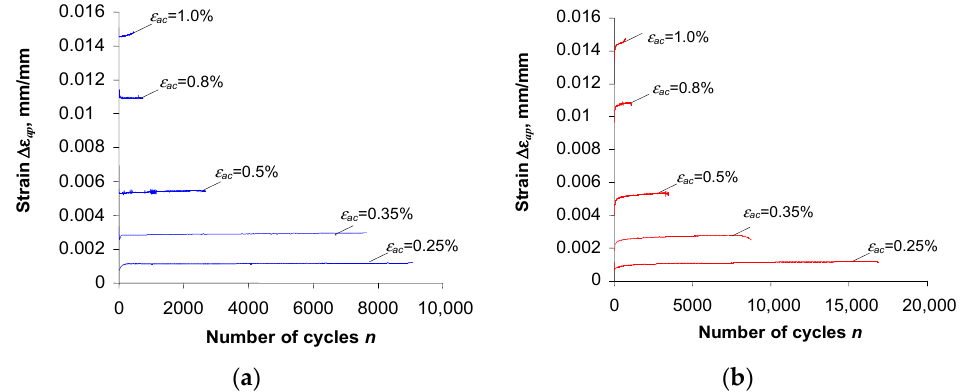
Figure 5. Stress amplitude 𝜎 𝑎 versus number of load cycle: ( a ) as-received specimens, ( b ) pre-strained specimens.